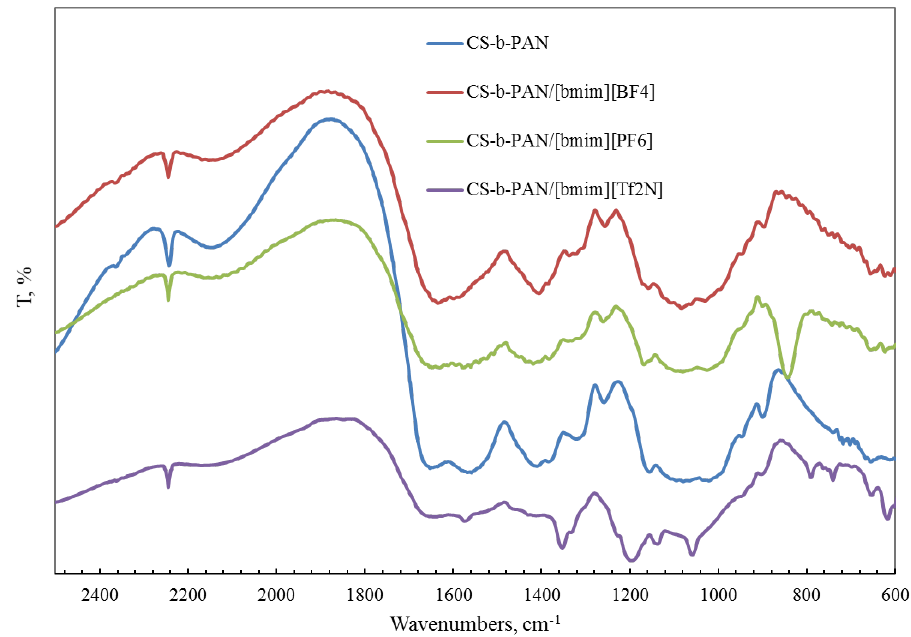
Figure 2. FTIR spectra of pure CS-b-PAN copolymer and CS-b-PAN copolymers doped with IL.